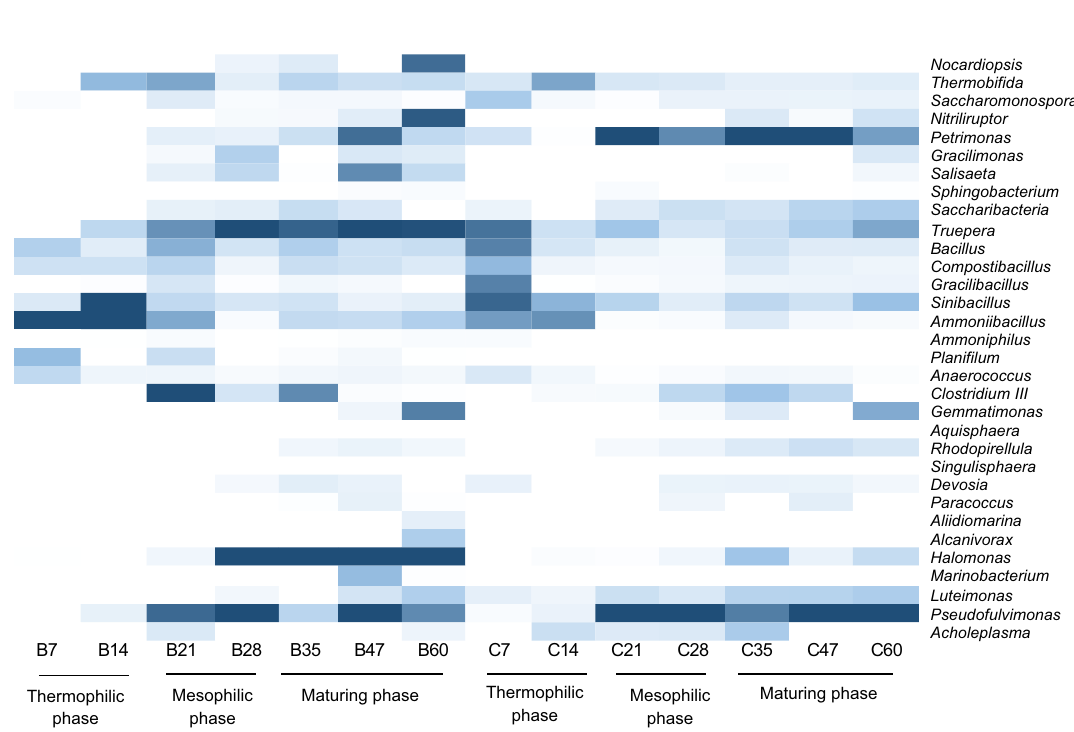
Figure 2. Heatmap analysis of the bacterial genera with the relative abundance of ≥ 0.1%. The (B) label denotes composting with biochar, while the (C) label denotes composting without